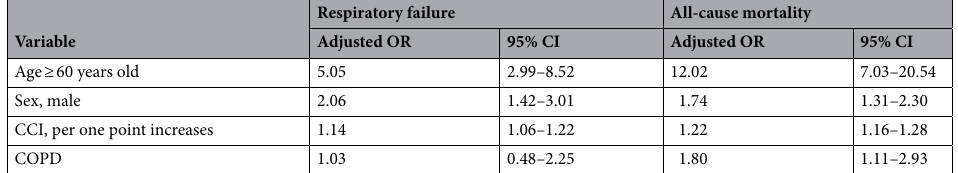
Table 3. Multivariate analyses of risk factors associated with respiratory failure and all-cause mortality. CCI Charlson comorbidity index, COPD chronic obstructive pulmonary disease, OR odds ratio, CI confidence